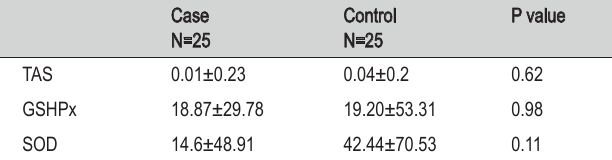
Table 4 - Comparison of mean and standard deviation of TAS, SOD and GSHPx between the two